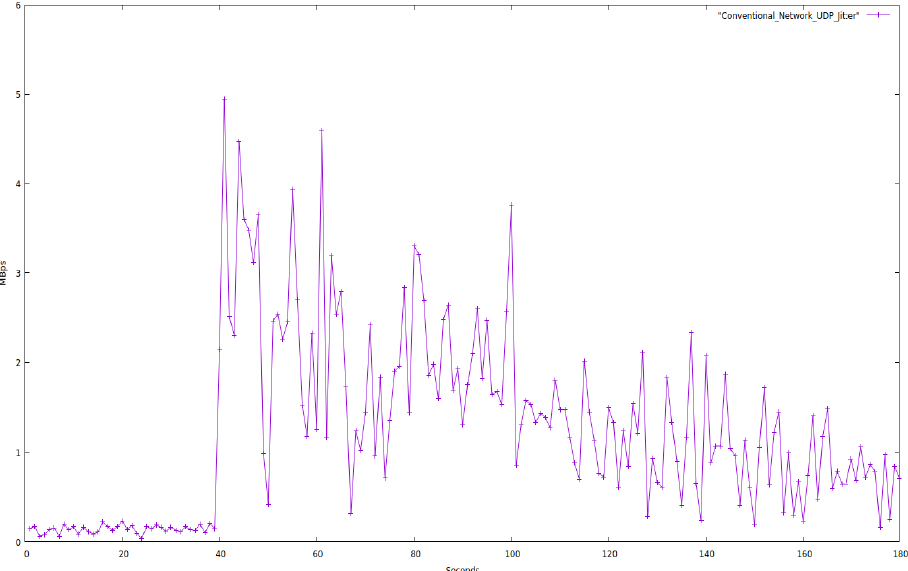
Figure 10. Jitter variation in Traditional Network.